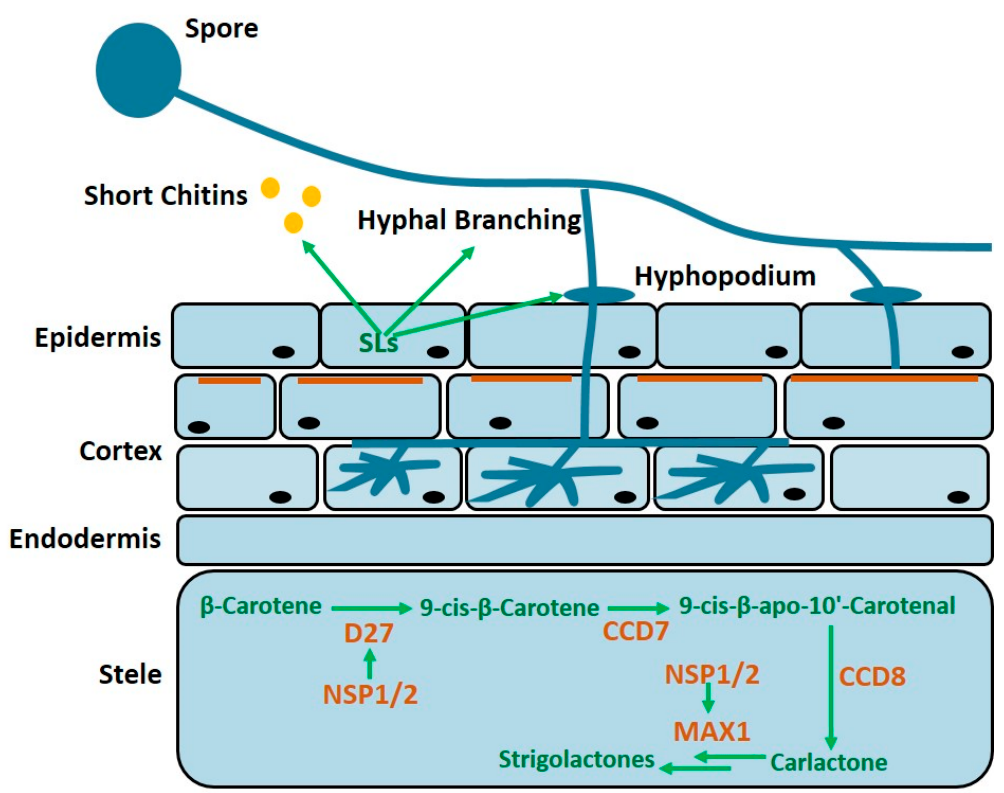
Figure 1. Summary of Strigolactones (SLs) biosynthesis and the effect of SLs on AM development. The biosynthesis of SLs, partially localized in the vasculature of the entire plant, where the D27, CCD7, CCD8, NSP1, NSP2, and MAX1 are all involved in the biosynthesis of SLs [11]. PDR1 protein (brown solid line) is apically localized in the outer cortex [31]. SLs induce the production of a short chitin (CO4, CO5) by the AM fungi, promote hyphal branching [25], and is required for the formation of hyphopoduim [30].